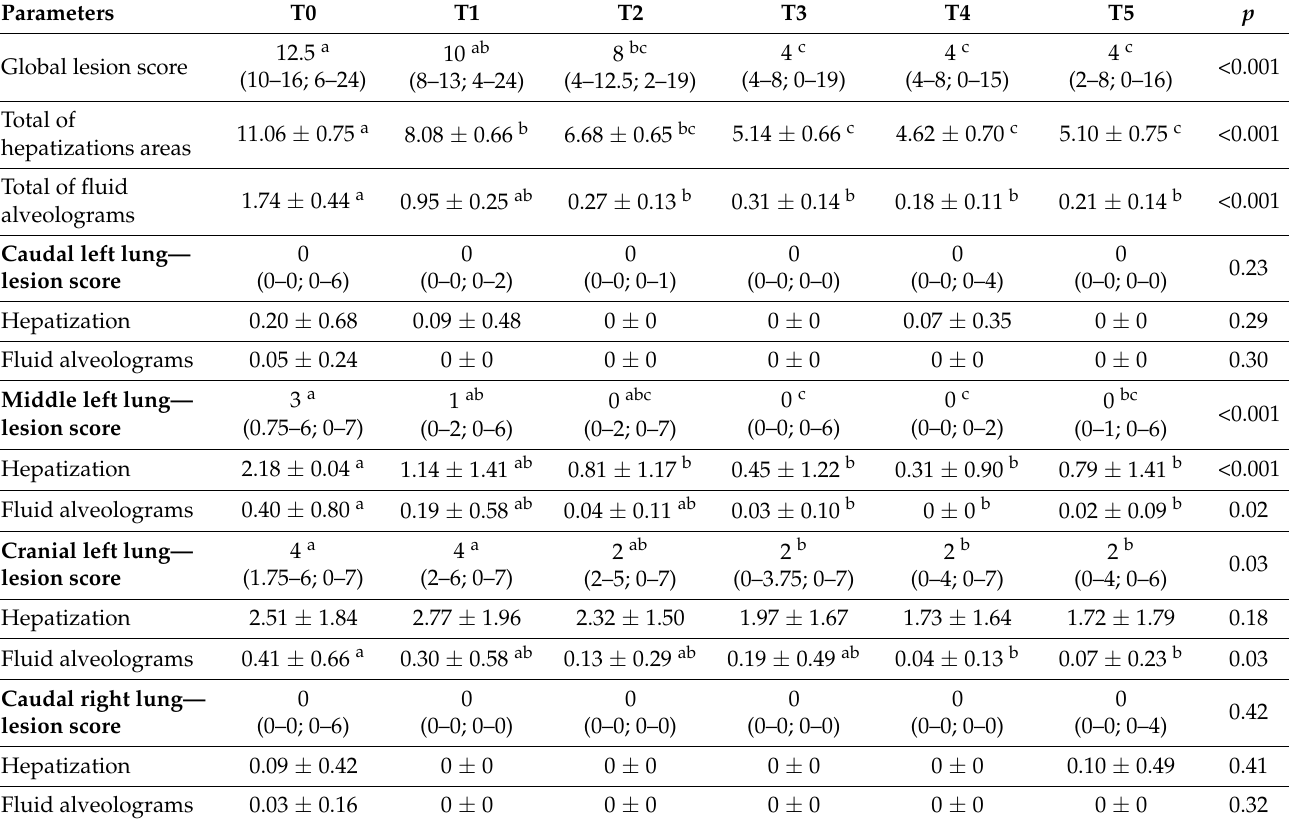
Table 4. Lung evaluations’ trend of group D (n = 31) at T0 (Time 0; day of restocking), T1 (Time 1;